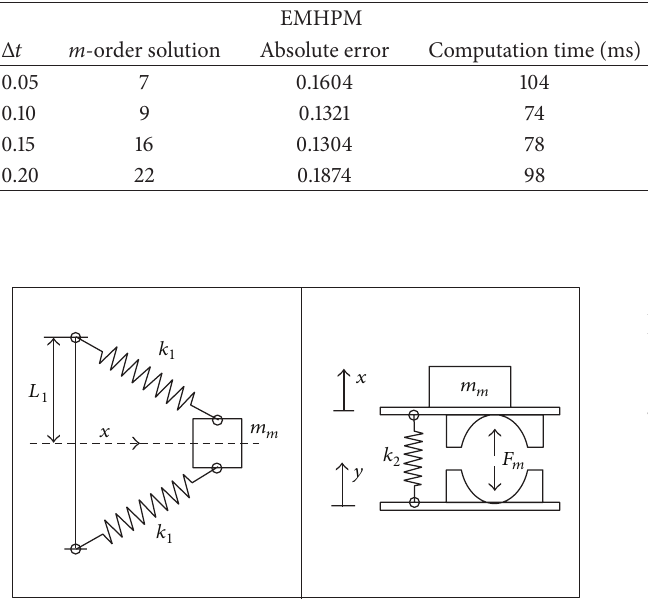
Figure 10: Solution of the nonlinear spring oscillator with Δ𝑡 = 10